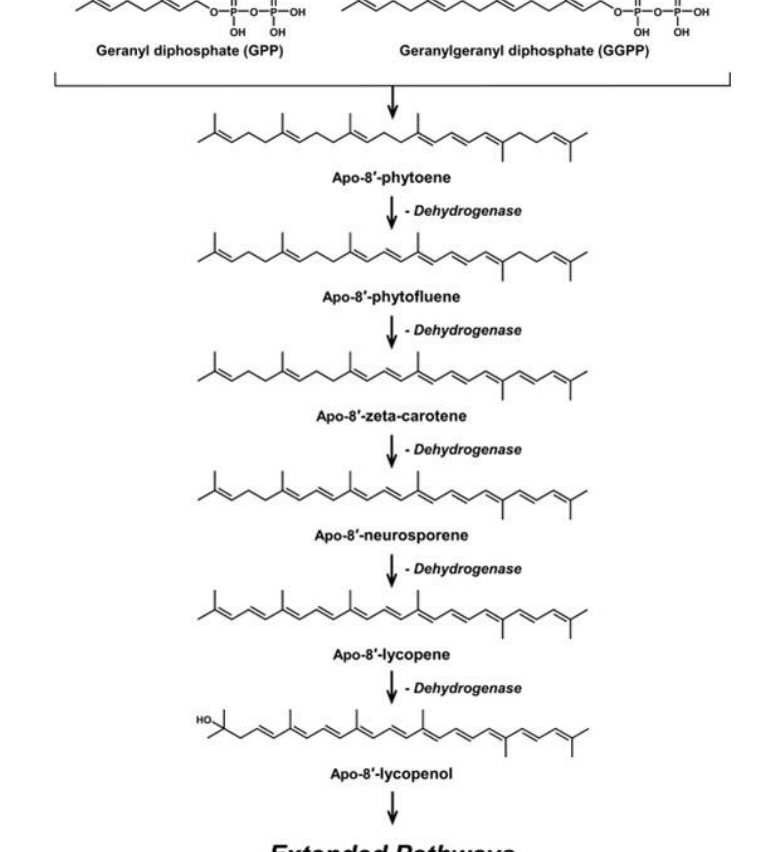
Figure 4. Biosynthetic pathway of Apo- 8′ -carotenoids.